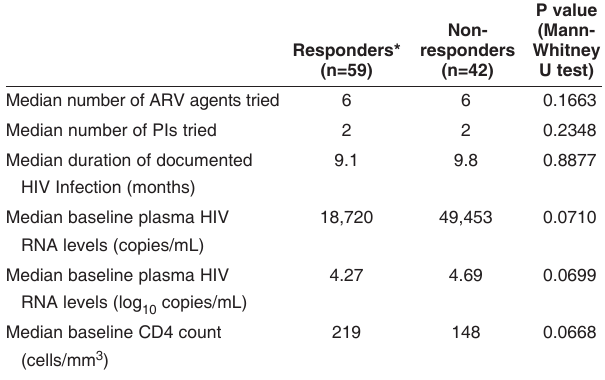
TABLE 2 Predictors of virological